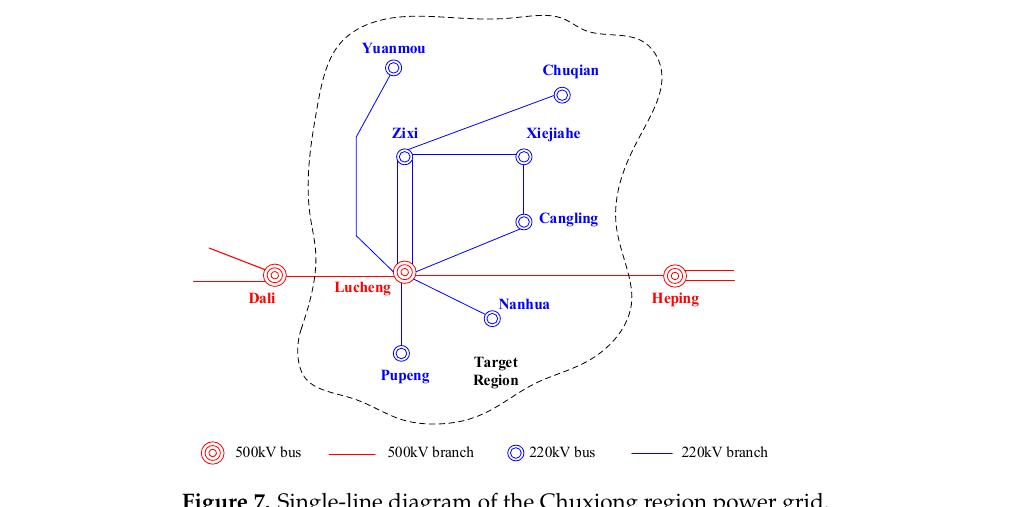
63 Table 3. Parameters of the induction motor. Item